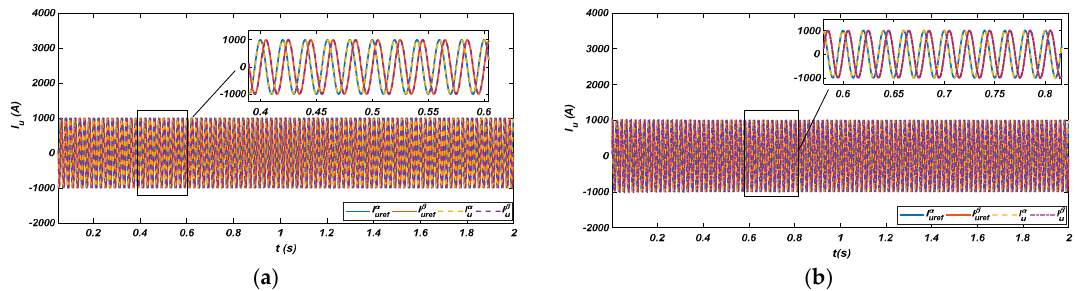
Figure 16. ( a ) Output current using the API controller; ( b ) output current using the PR controller.